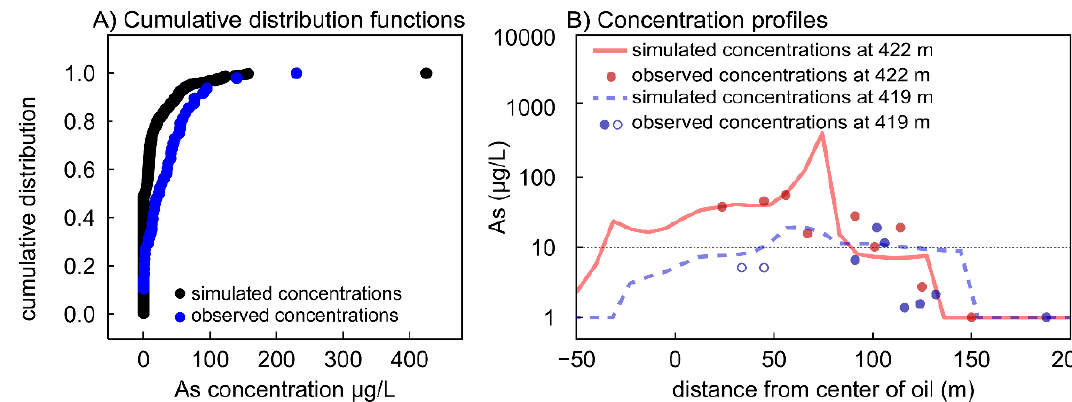
Figure 3. Comparisons of observed As concentrations from well sampling (data in [29,31]) and simulated concentrations from the calibrated model. ( A ) Cumulative distribution functions for dissolved As concentrations 37 years after the spill. Model simulation data ( n = 480) are shown in black; observed concentrations from well sampling ( n = 48) are shown in blue. ( B ) Arsenic concentration profiles at elevations of 422 m (red), and 419 m (blue) for 37 years after the spill. Simulated concentrations are shown in lines and observed concentrations from well sampling are shown in circles. Open circles designate samples that were reported as <10 µg/L, and thus are plotted at half the detection limit. The dashed horizontal line shows the 10 µg/L MCL for As.